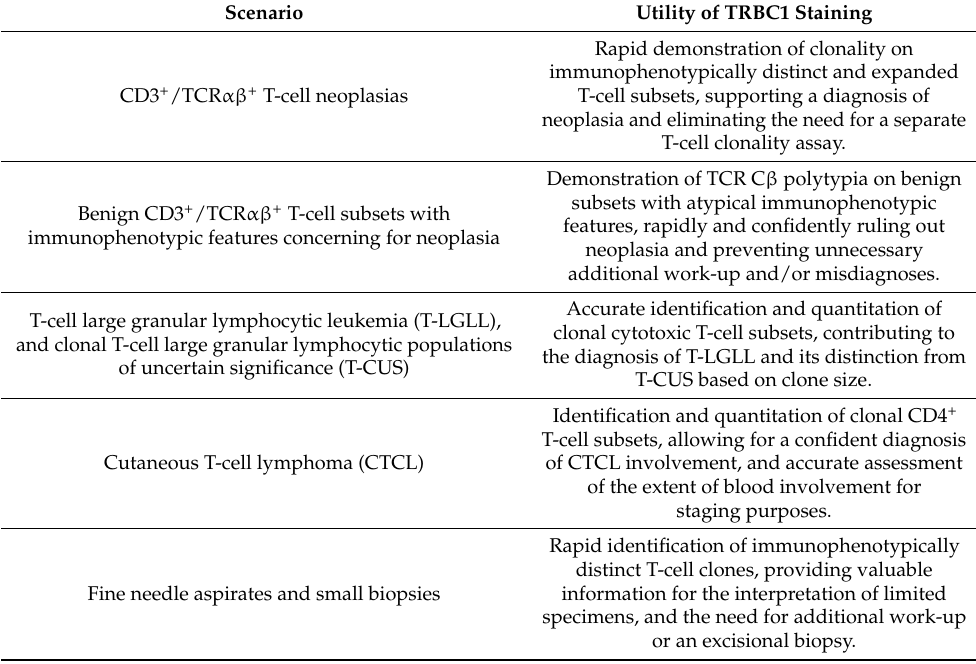
Table 1. Role of T-cell receptor β chain constant region 1 (TRBC1) staining in the flow cytometric evaluation of clinical